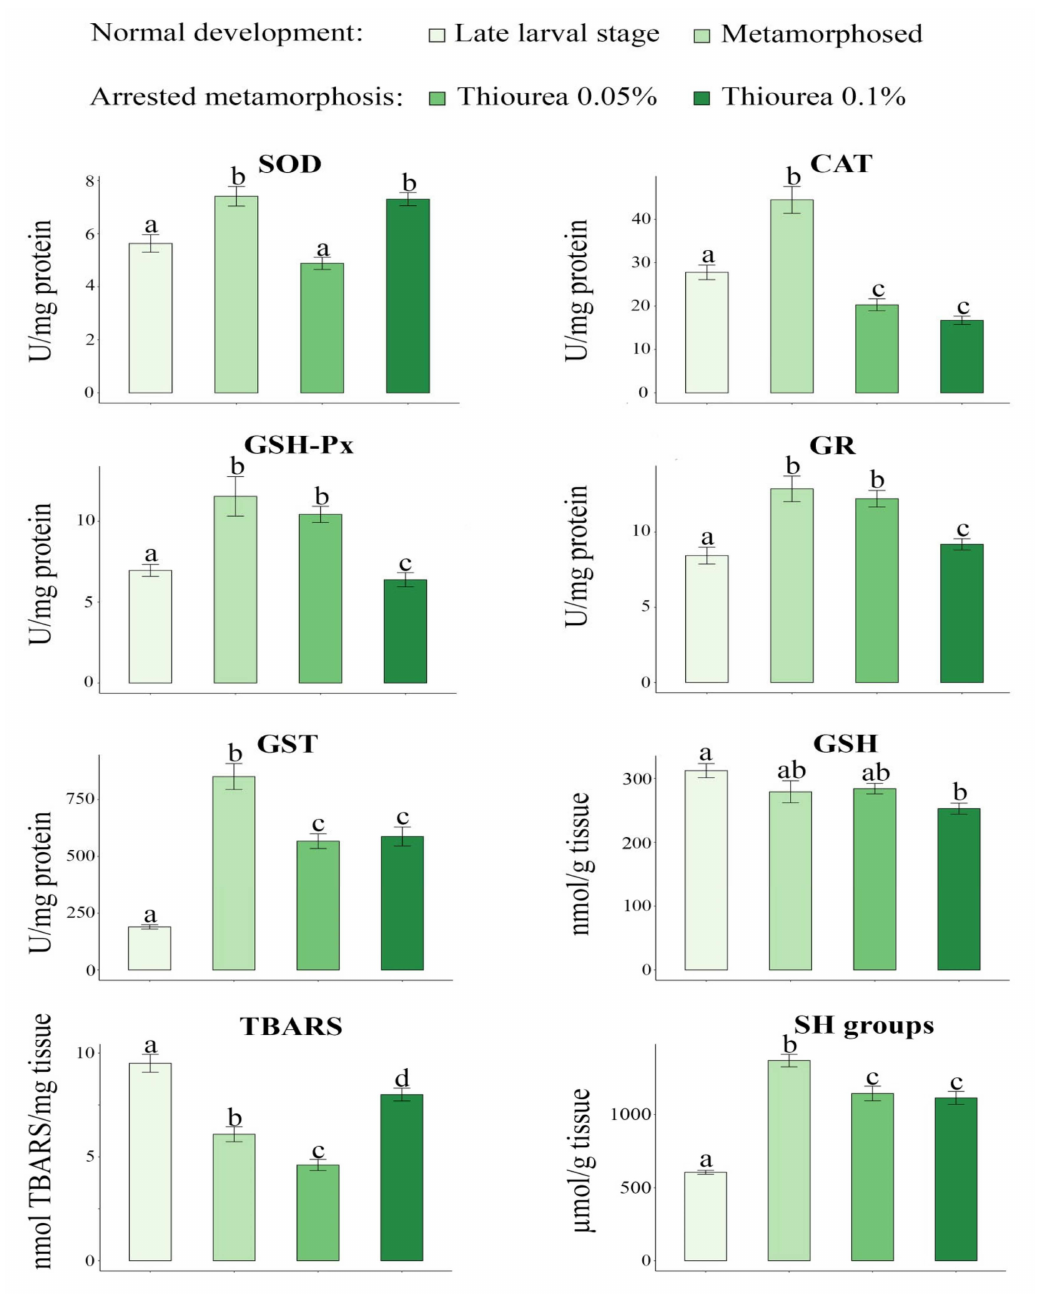
Figure 1. Oxidative stress parameters: superoxide dismutase (SOD), catalase (CAT), glutathione peroxidase (GSH-Px), glutathione reductase (GR), glutathione-S-transferase (GST), glutathione (GSH), thiobarbituric acid reactive substances